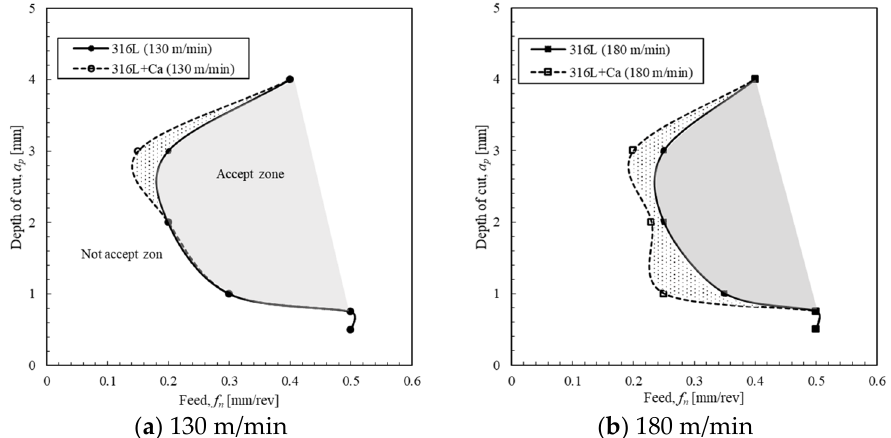
Figure 1. Chip breaking curve at cutting speeds of 130 m/min ( a ) and 180 m/min ( b ).